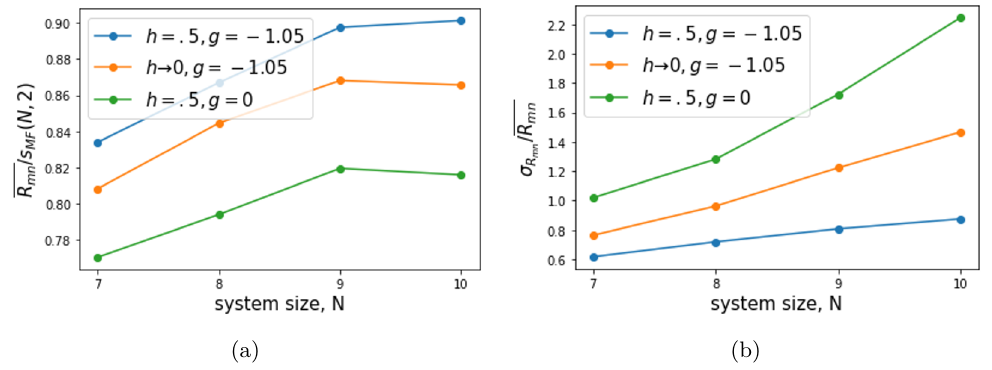
Figure 29 . Comparison of the average and standard deviation of the R mn matrix in the chaotic and integrable regimes showing (a) the scaling of the average off-diagonal element divided by the proportion of simple operators ( N = 9 , k = 2 ), and (b) the scaling of the standard deviation with system size ( k = 2